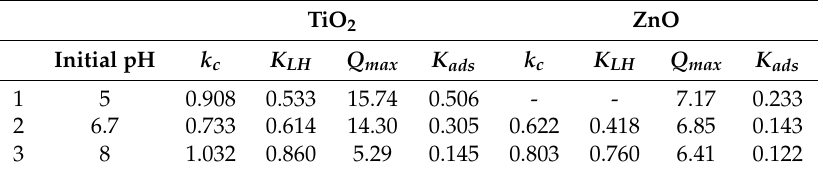
Table 2. Determination of the L–H equilibrium adsorption constant ( K LH in L / mg), the rate constant of the surface reaction ( k c in mg / L min), Langmuir adsorption constant ( K ads in L / mg), and maximum absorbable dye quantities ( Q max in mg / g) of FB1 at di ff erent pH values ([TiO 2 ] = 0.8 g / L, [ZnO] = 1.2 g / L, and T = 25 ◦ C). TiO 2 ZnO Initial